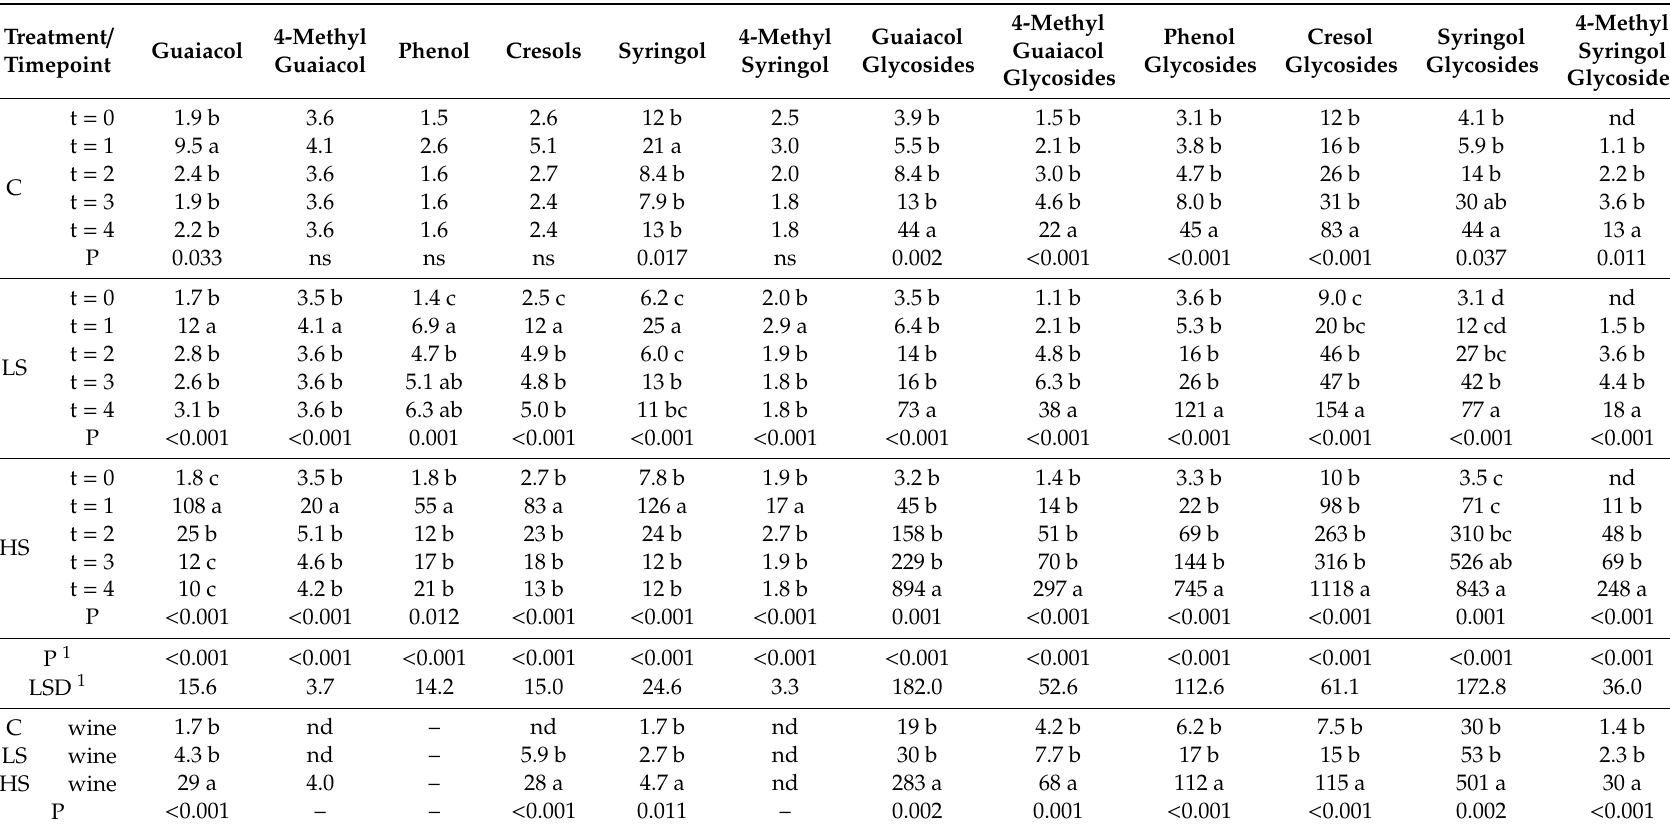
Table 1. Concentrations of volatile phenols in juice ( µ g / L) and volatile phenol glycosides in homogenate ( µ g / kg) from control and smoke-exposed grapes sampled from pre-smoke exposure (t = 0) to maturity (t = 4), and in corresponding wines ( µ g / L); di ff erent densities of smoke were achieved by burning di ff erent amounts of